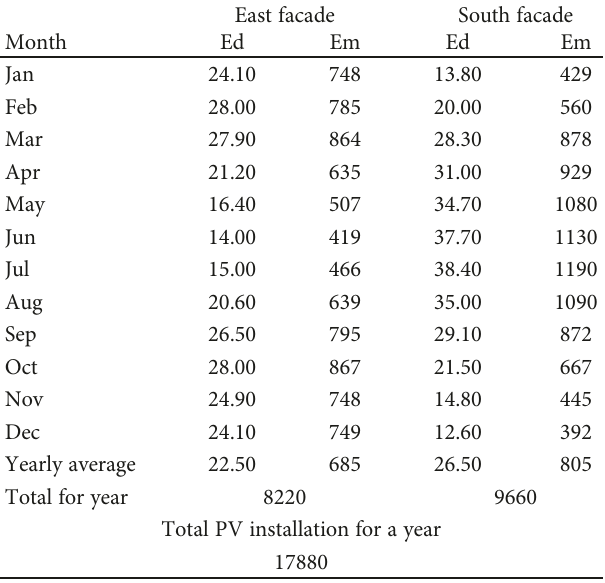
Figure 5: Schematic diagram of the BIPV modules installed in the south and the east facades. Table 1: Average daily and monthly expected electricity production (kWh) from the PV modules installed on the two considered facades, obtained from the PVGIS software [16].